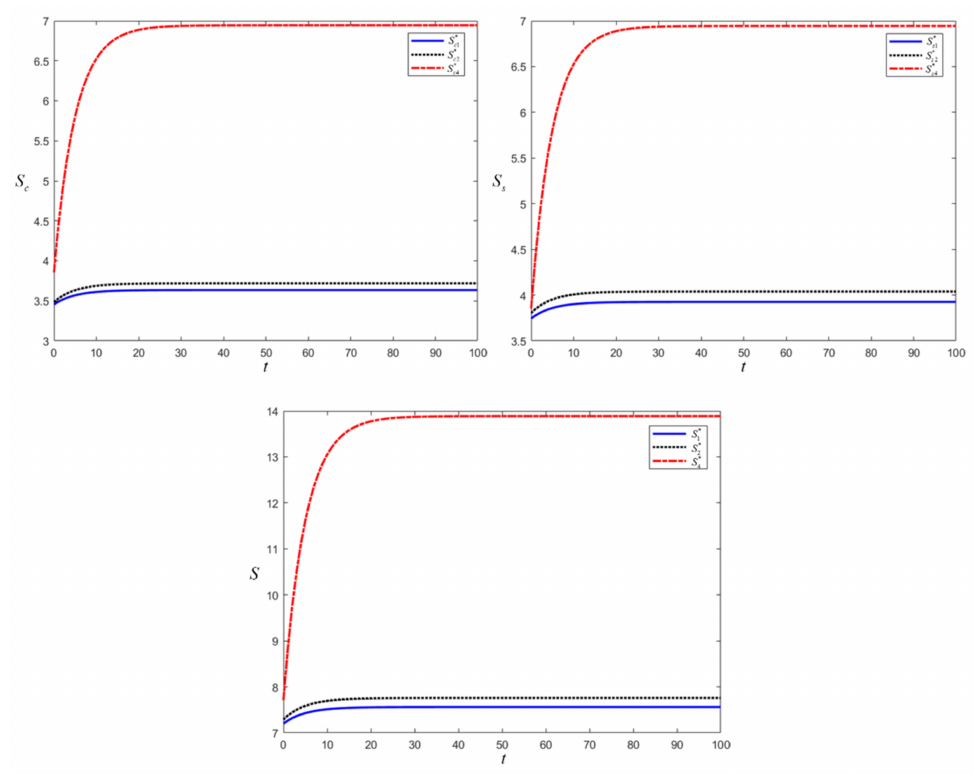
Figure 3. Optimal revenue function of manufacturer, EP and SC under three game scenarios.